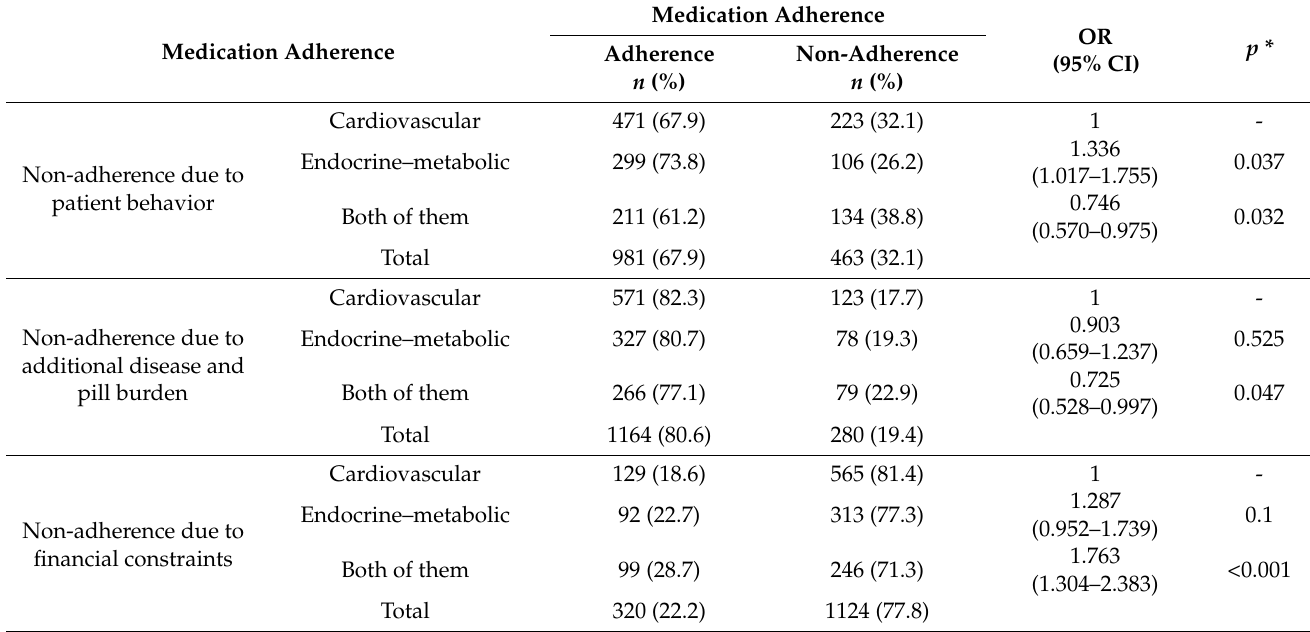
Table 3. Adherence features according to the GMAS in each disease